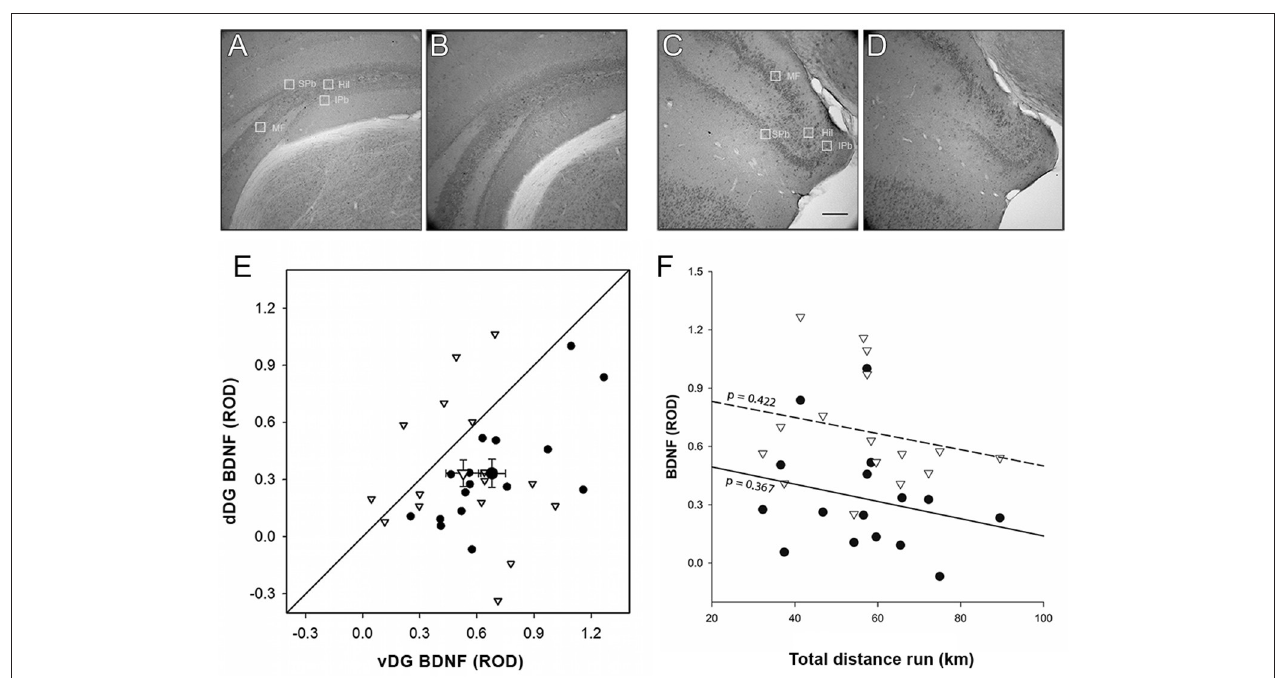
FIGURE 6 | BDNF Morphological analysis. Optical density of BDNF immunohistochemistry was significantly higher [ χ 2 (1) = 18.180, p < 0.001] in both EvDG (C) and CvDG (D) compared to their dorsal counterparts ( A,B, respectively) Scale bar : 70 µ m. The great variability found in E animals gave no significant difference from C animals which were mostly distributed below the identity line in plot (E) . Enriched environment did not have an effect on BDNF immunoreactivity [ χ 2 (1) = 0.802, p = 0.371]. No significant interaction was found between experimental treatment and region [enrichment*region: χ 2 (1) = 1.398, p = 0.237]. Legend for (E) as in Figure 3G . (F) The effect of distance run, plotted against BDNF ROD showed no significant effects. Legend for (F) as in Figure 3H .